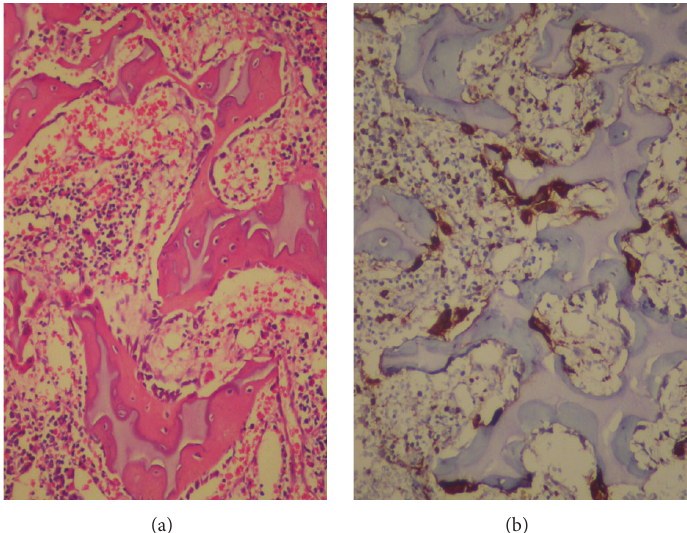
Figure 1: (a)Bonemarrowbiopsy: hypocellular bonemarrow, enlarged and thickened bone trabeculae with encroachment onmarrowspaces, and a mosaic pattern with cartilaginous islands (HE × 100) and (b) TRAP staining of bone biopsy specimens: increased number of osteoclasts (DAB × 200).